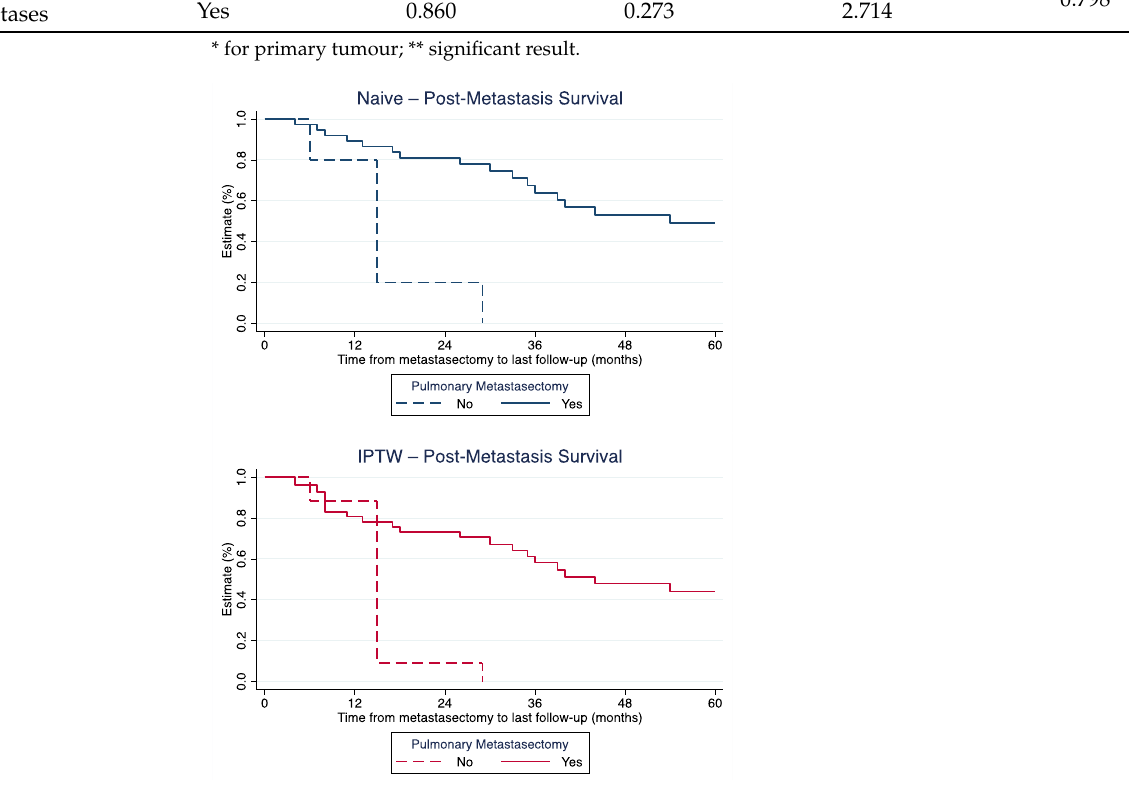
Figure 1. Post-metastasis survival for patients with and without metastasectomy, before ( top ) and after ( bottom ) IPTW-adjustment. Patients with multiple metastases had a significantly worse PMS than patients with solitary lung metastases (HR: 2.858; 95%CI: 1.173–6.967; p = 0.021). The same was the case for a metastasis-free interval of <9 months compared to an interval of >=9 months (HR: 0.255; 95%CI: 0.114–0.573; p = 0.001). There was no significant difference in PMS between patients with underlying osteosarcoma, Ewing sarcoma, and other histologies (Table 2). Due to the remaining imbalances after IPTW weighting, reflected by insufficient re- duction in SMDs for some variables, multivariate analyses taking into consideration time to pulmonary metastases, patient age, and singular vs. multiple metastases, were per- formed. In this multivariate Cox-regression model, the significant positive influence of metastasectomy towards improved PMS prevailed (HR: 0.279; 95%CI: 0.118–0.662; p = 0.004; Table 2), irrespective of patient age ( p < 0.001), time to pulmonary metastasis ( p = 0.003), and presence of multiple metastases ( p = 0.798). 3.3. Long-Term Post-Metastasis Survival Twelve patients had a PMS of at least 5 years (median 98.0 months (IQR: 81.5–117.0 months)). All of them had undergone pulmonary metastasectomy (Table 3). Seven of the twelve patients had more than one pulmonary lesion at time of diagnosis of metastatic disease. Two patients presented with primary lung metastases, whilst the remaining ten developed secondary pulmonary lesions. Nine patients had been diagnosed with osteo- sarcoma, two with chondrosarcoma, and one with Ewing sarcoma. Six patients developed further metastases following initial metastasectomy (Table 3), and four of these subse-